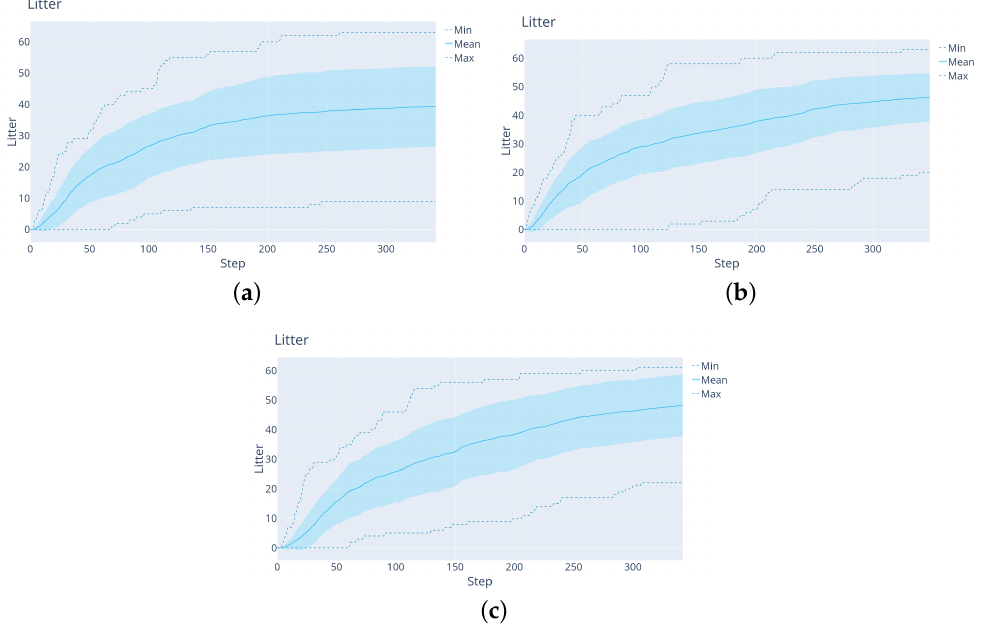
Figure 15. Rainbow agent performance for varying entropy influence on the rewards. From the left: ( a ) No entropy reward. ( b ) Entropy reward parameter h = 100. ( c ) h = 100.